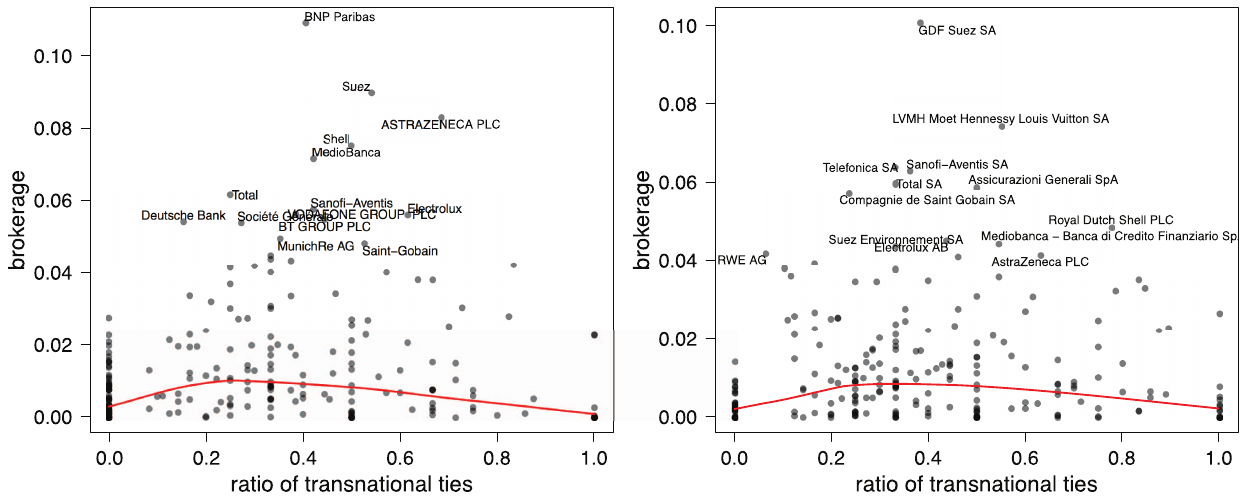
Figure 5. Brokerage against transnational character in 2005 (Left) and 2010 (Right). Each point in the plane corresponds to a company; x and y coordinates define its normalized node betweenness (brokerage) and its ratio of transnational edges, respectively. For readability reasons, only company names in the upper 0 : 95 -quantile of the betweenness distribution are shown.